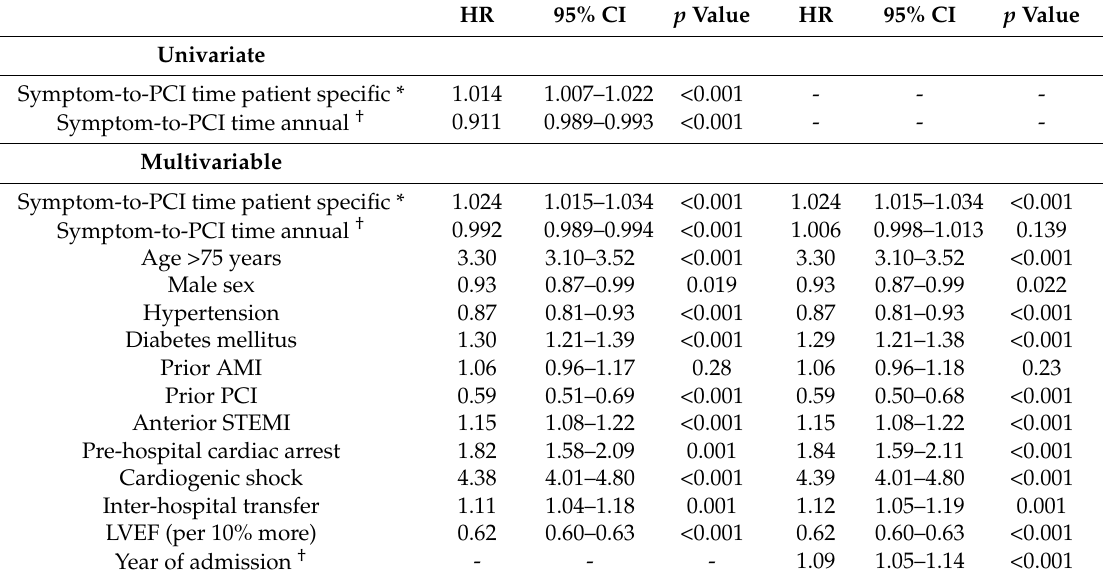
Table 3. Cox proportional regression analysis of one-year case fatality. HR 95%